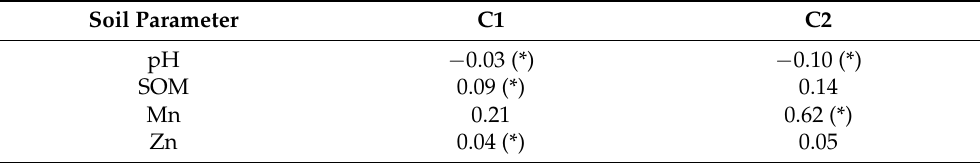
Table 2. Mean differences in planned contrasts (C1 and C2) on the soil parameters (pH, soil organic matter (SOM), manganese (Mn) and zinc (Zn)) where the treatments had a significant effect. The results were significant at * p < 0.05.